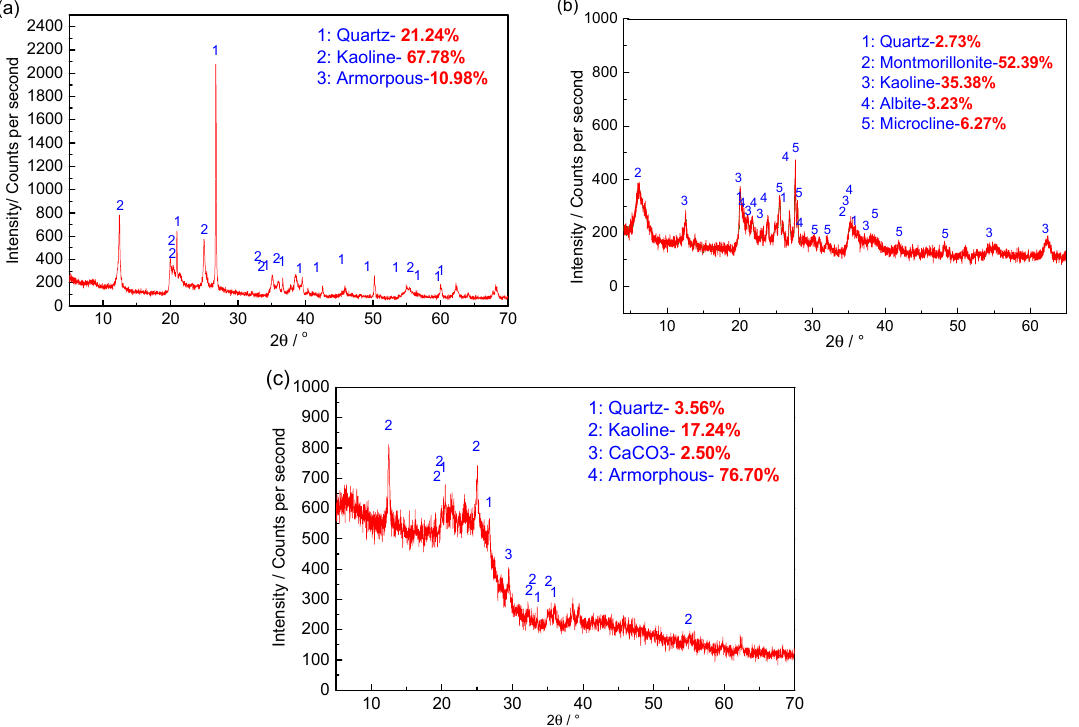
Figure 8. Mineral compositions of ( a ) shale, ( b ) mudstone and ( c ) coal.